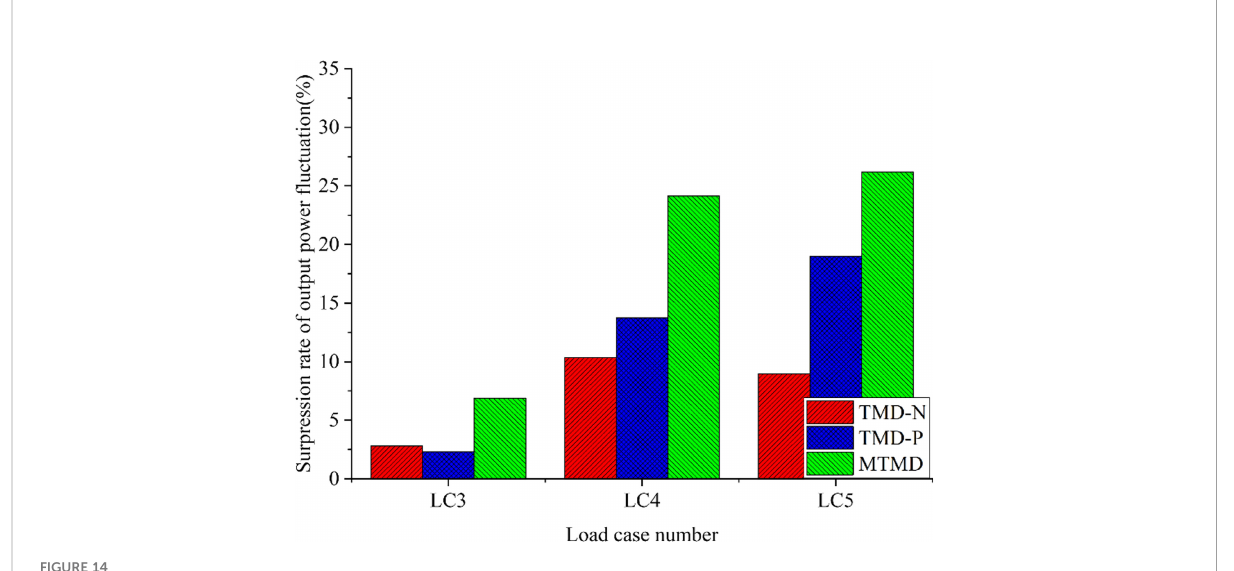
FIGURE 14 Standard deviations of the output under different load